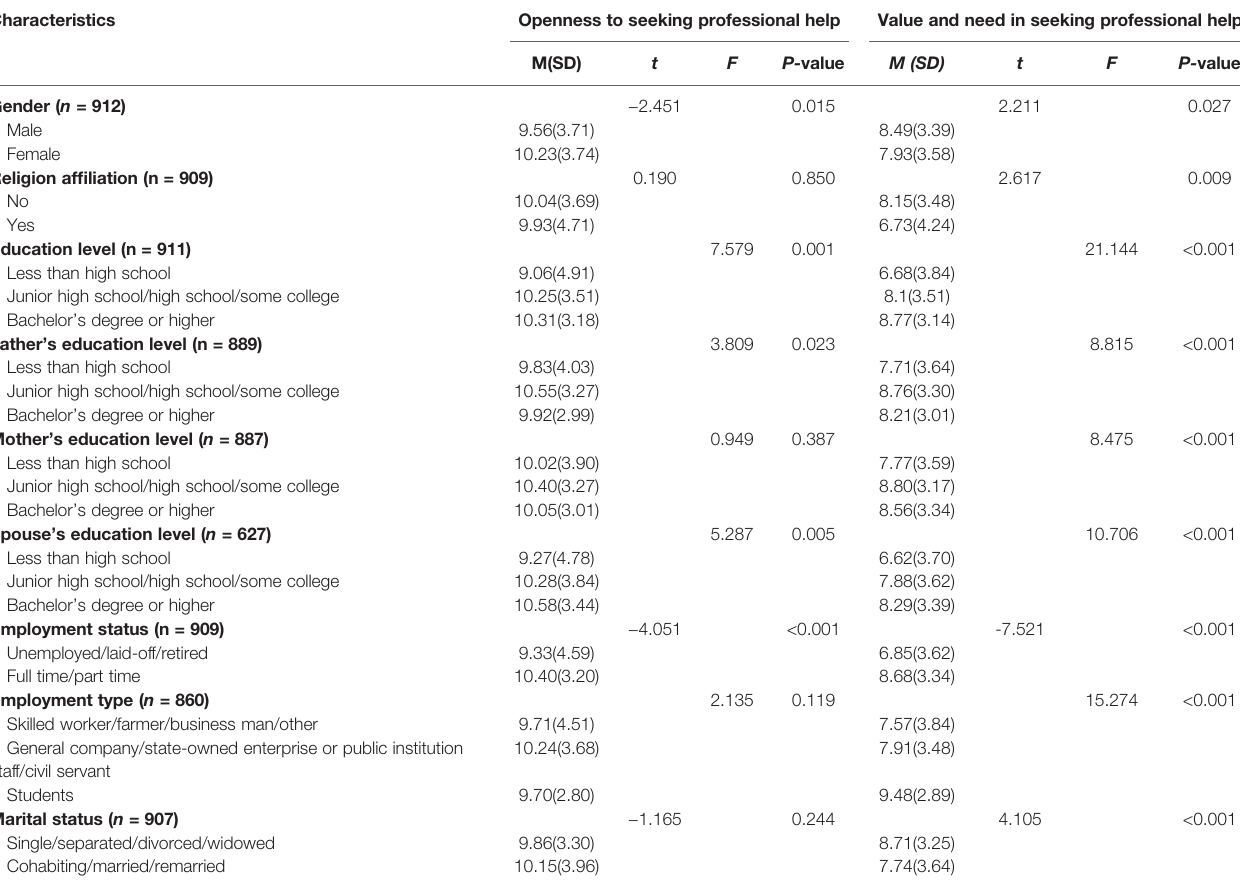
TABLE 3 | Comparison of the ATSPPH-SF scores by socio-demographic characteristics. Characteristics